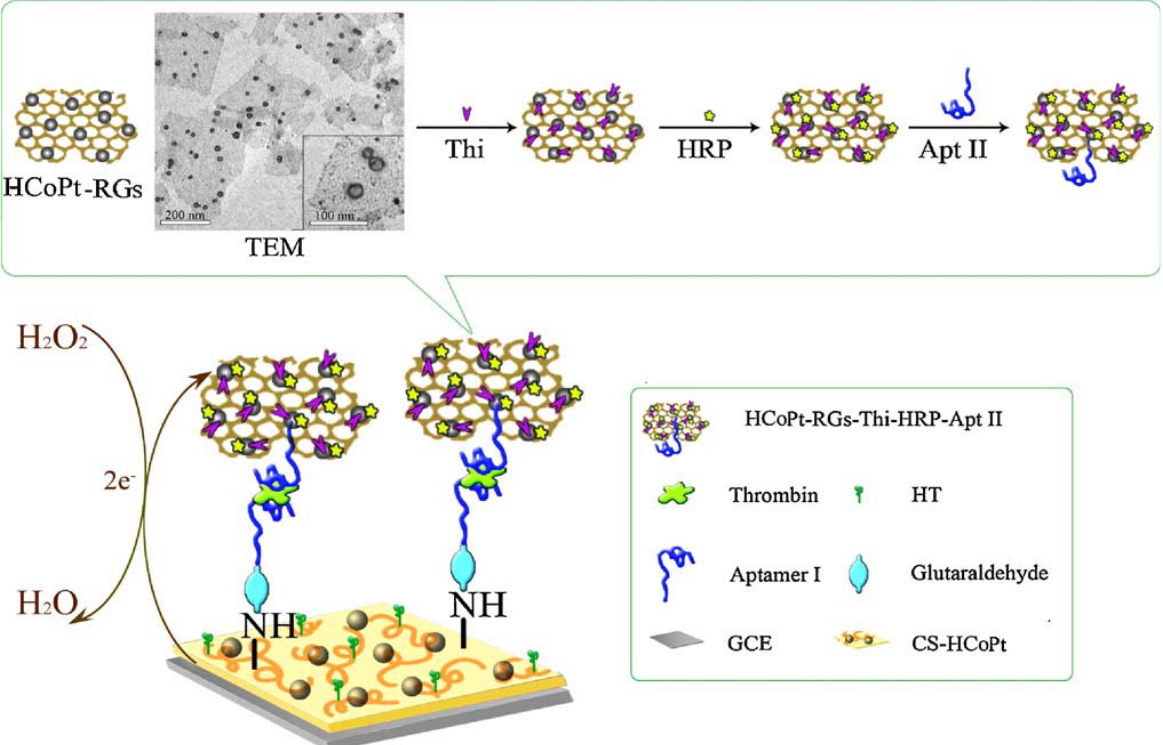
Scheme 1. Schematic diagrams of preparation of the sandwich-type electrochemical aptasensor and TEM images of the hollow CoPt alloy nanoparticles decorated